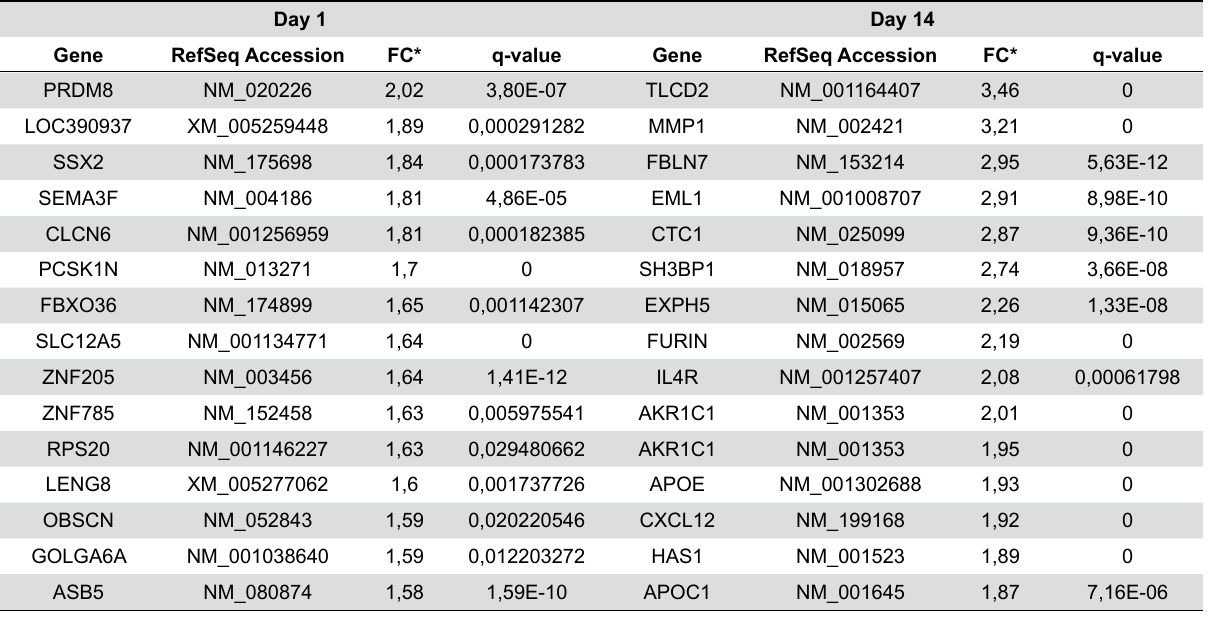
Table 1- Top 15 most up-regulated genes under high glucose condition